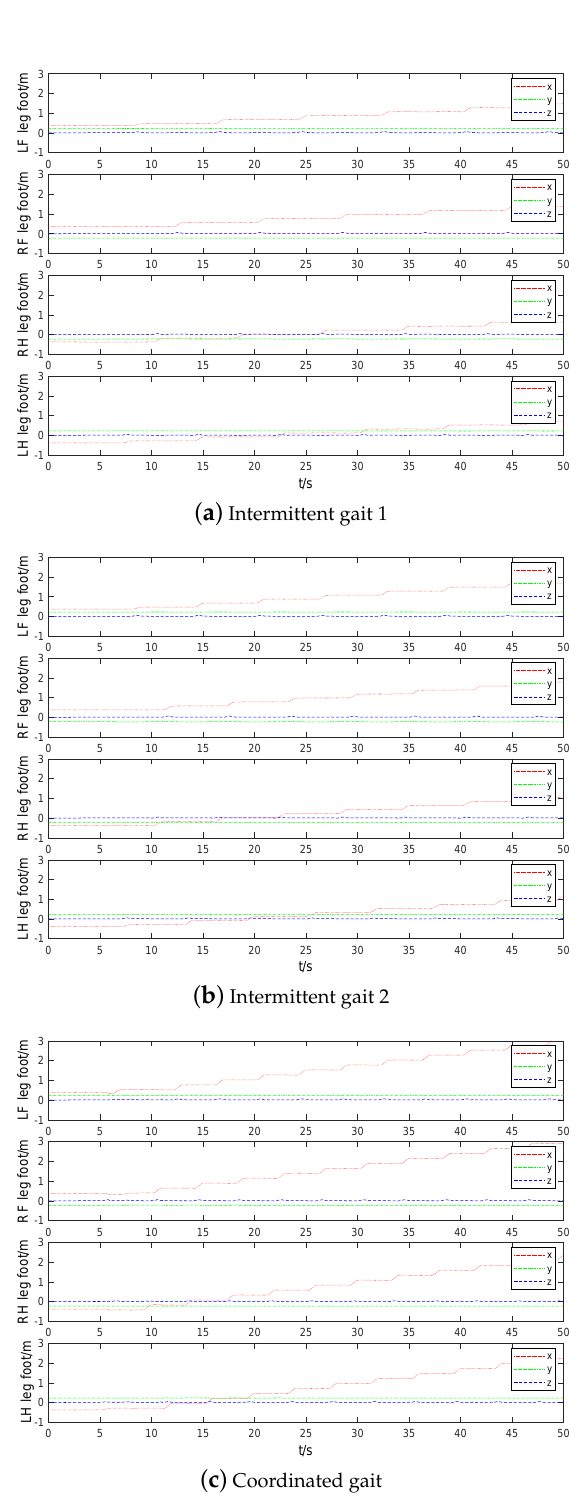
Figure 12. Comparison of foot end-effector of three static